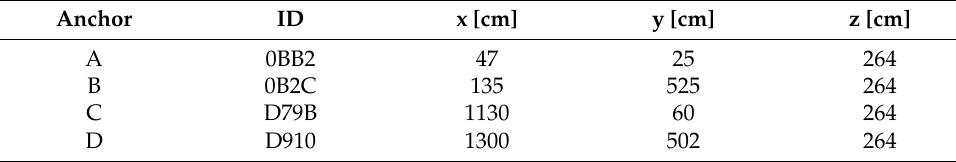
Table 2. Coordinates of the reference points (tag positions).